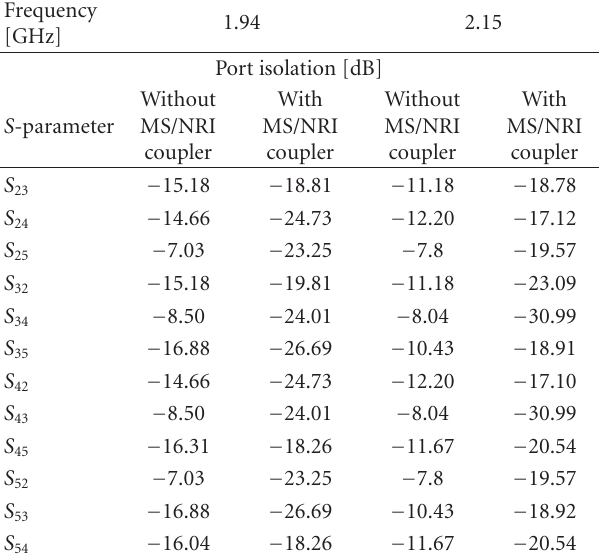
Table 3: Simulated S -parameters of the feed network for a four- element microstrip patch array.